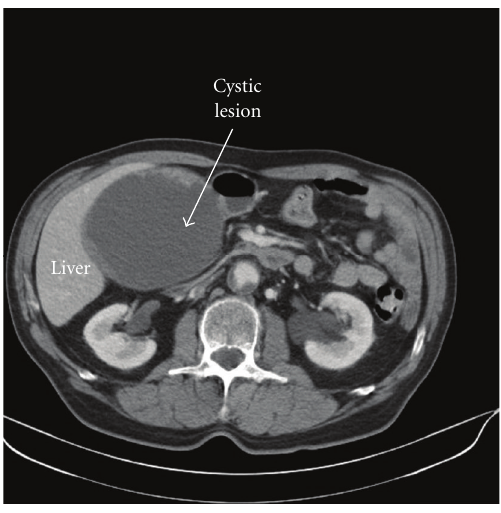
Figure 2: Abdominal computed tomography (CT) displaying a large cystic lesion (arrow) adjacent to the right liver lobe, the stomach, and the pancreatic head.